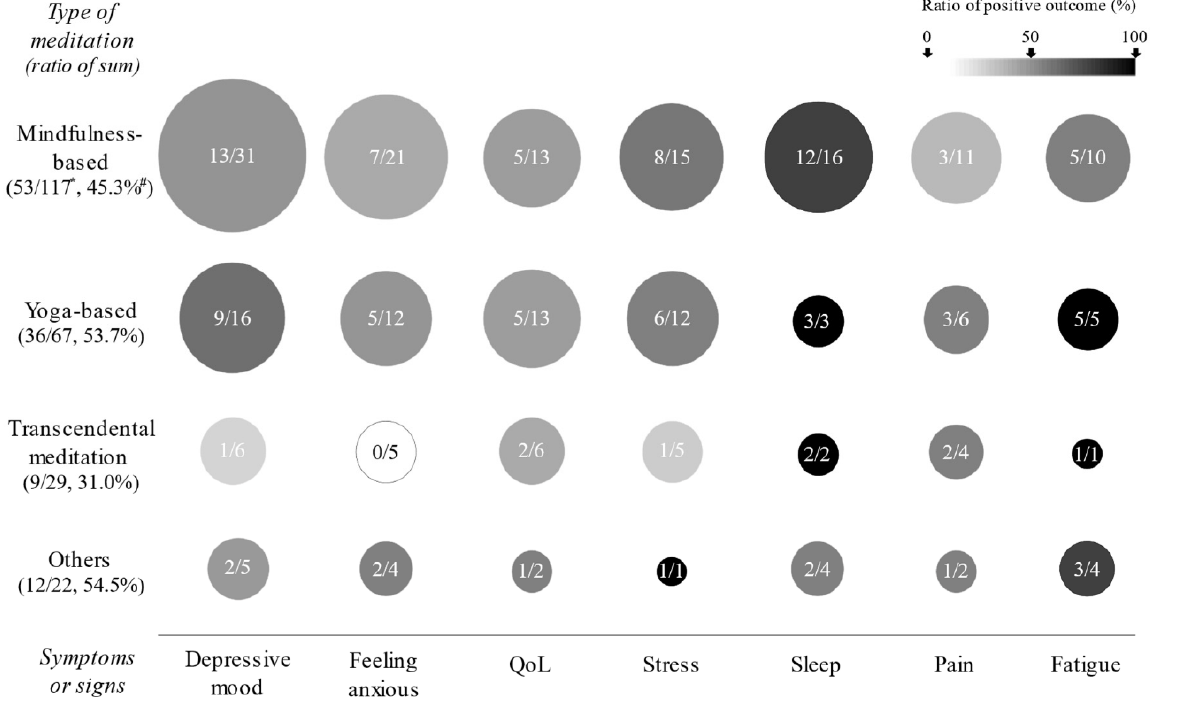
Figure 4. The features of significant outcomes in the RCTs according to the types of meditations. Regarding all measurements, the seven most frequently assessed outcomes are displayed according to the types of meditations. The circle’s size and level of darkness indicate the number of RCTs and the ratio of positive outcomes, respectively. The positive outcome indicates that treatment achieved statistical significance compared to the control ( p < 0.05 or Cohen’s d > 0.5). */# indicates the total number of outcomes measured for the seven symptoms in the RCTs for patients with given disorders and positive outcomes, and their ratio.